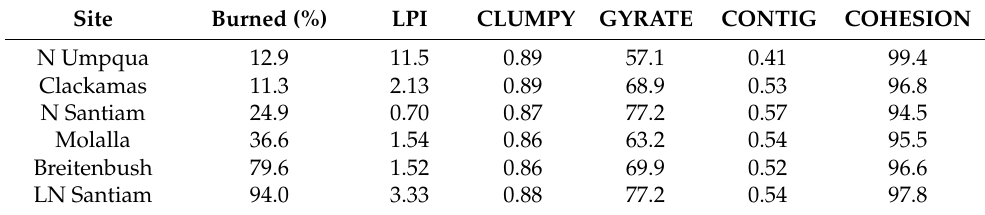
Table 3. Landscape metrics calculated for the high severity patches in each burned watershed. Site Burned (%)